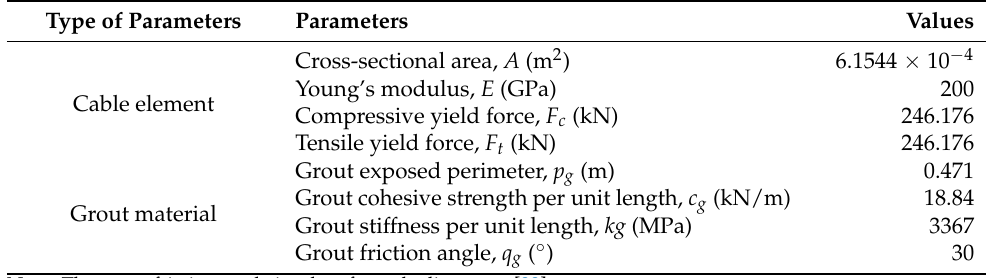
Table 3. Parameters of the cable-grout-soil